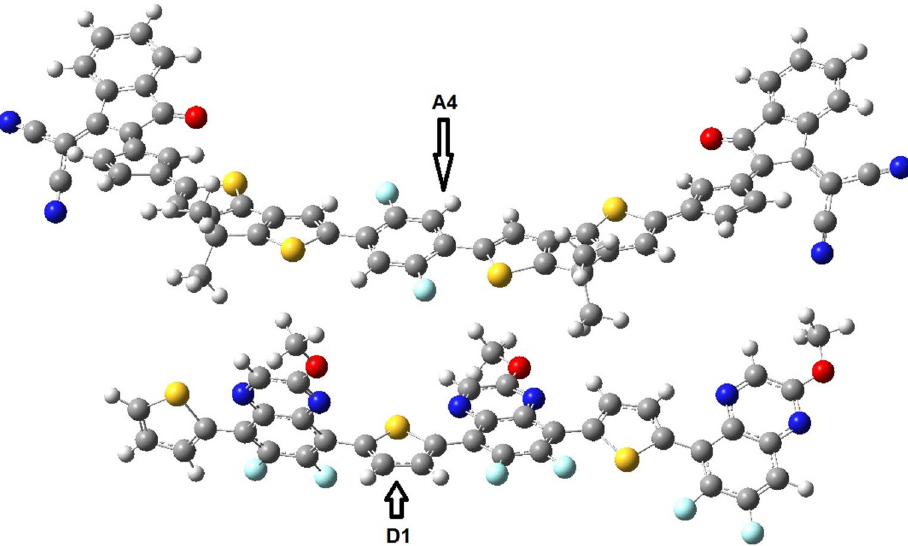
Figure 6. Optimized geometry of blend of D1 – A4 at B3LYP 6-31G (d,p).